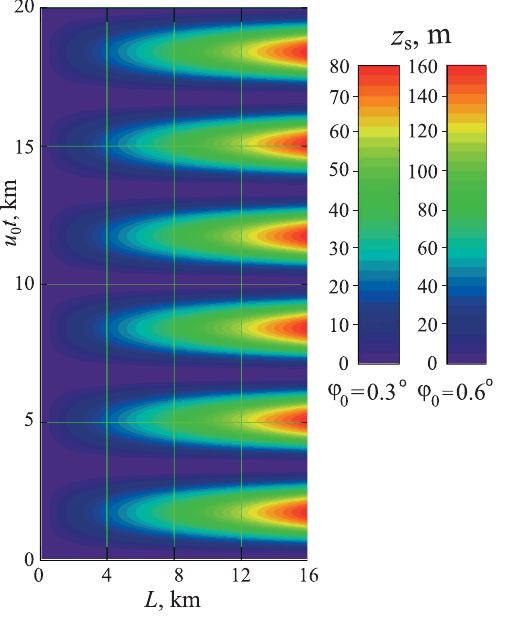
Figure 4. Deviation z S of the scattering volume center from the flight direction as a function of the pulse generation time t and of the distance L .